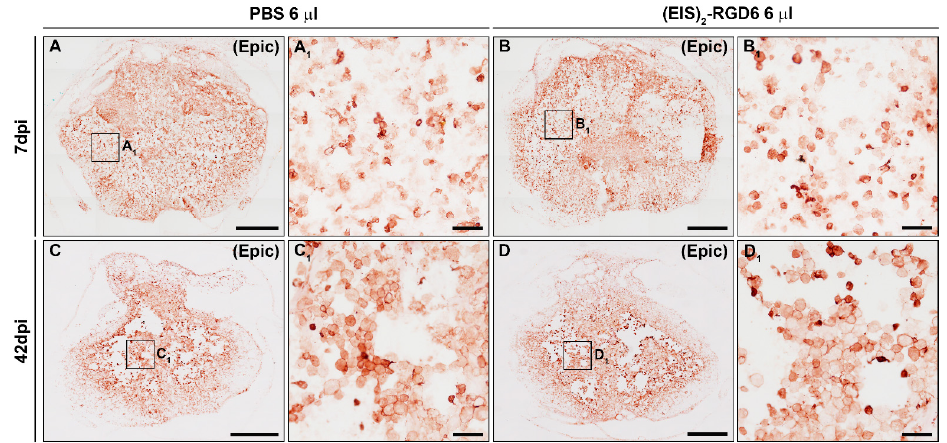
Figure 18. Representative images from ionized calcium-binding adaptor molecule 1 (Iba1) immunostained sections. Representative images of Iba1 immunostained spinal cord sections corresponding to the lesion epicentre, used to carry out the densitometrical analysis of microglia/macrophage reactivity in experiment (EIS) 2 -RGD6 III at 7 and 42 days post-injury (dpi): ( A , A 1 ), PBS 6 µL group at 7 dpi; ( B , B 1 ) (EIS) 2 -RGD6 6 µL group at 7 dpi; ( C , C 1 ), PBS 6 µL group at 42 dpi; and ( D , D 1 ) (EIS) 2 -RGD6 6 µL group at 42 dpi. Scale bars in ( A – D ), 500 µm. Scale bars in ( A 1 – D 1 ), 50 µm. Please note that data obtained from the densitometric analysis of microglia/macrophage reactivity in these sections can be found in Figure 16C,D.